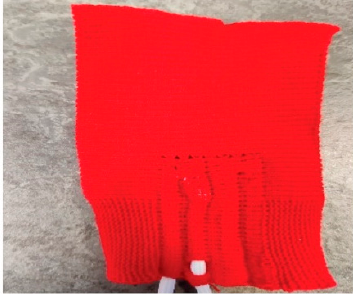
Figure 3. Image of a vibration-sensing E-yarn embedded into the testing fabric. This fabric was constructed using the same structure and materials of the final vibration-sensing glove.